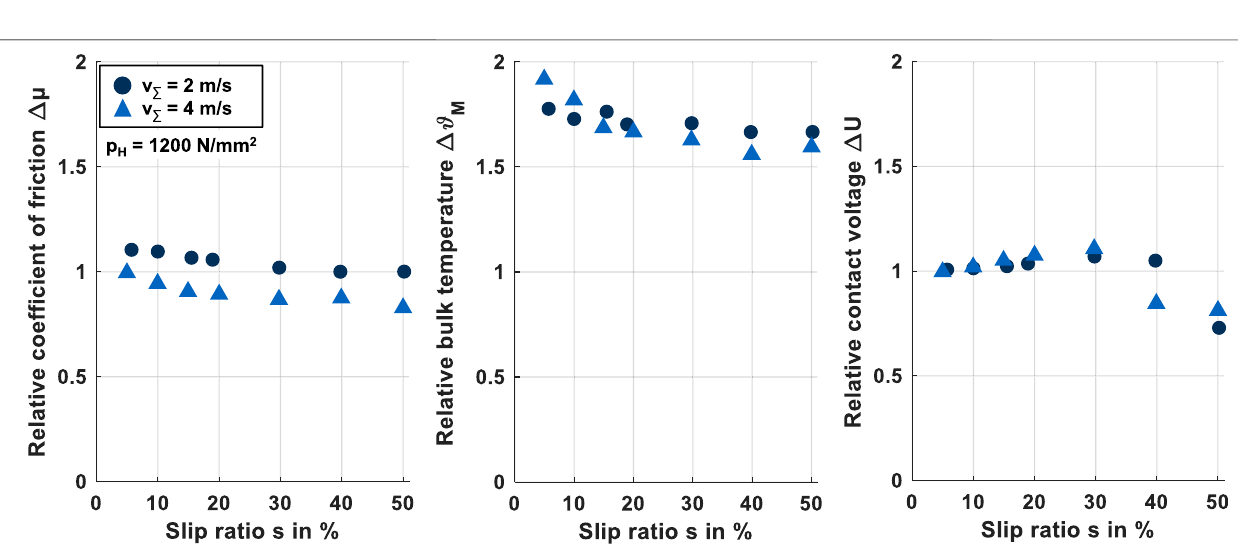
Frontiers in Mechanical Engineering |